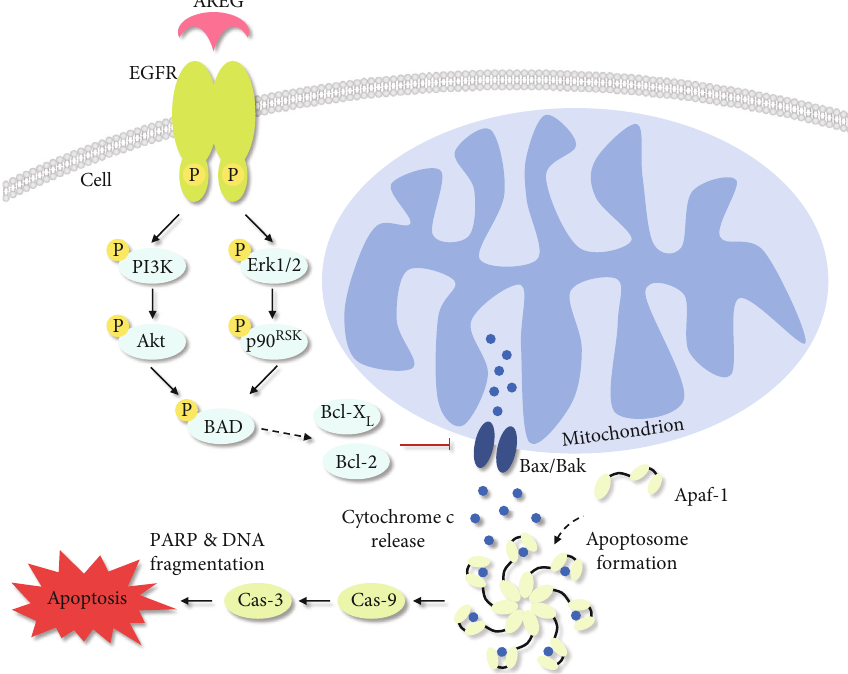
Figure 6: Schematic diagram displaying the impact of AREG on intrinsic apoptosis signaling. Phagocytosis of bacterial pathogens leads to the release of cytochrome c from the mitochondria through the mitochondrial apoptosis-induced channel (MAC), which is formed by the proteins Bax and Bak. In complex with Apaf-1, the released cytochrome c forms the apoptosome, which fi nally activates caspase-3 through binding and activation of caspase-9. Caspase-3 fi nally leads to the initiation of apoptosis. The signaling pathway can be inhibited by AREG-mediated activation of the EGF receptor. Binding of the cytokine AREG leads to an EGFR-mediated activation of the PI3K/Akt and MAPK/ERK pathway, which results in the phosphorylation of the protein BAD. In consequence, the heterodimers of BAD/Bcl-X L and/or BAD/Bcl-2 dissociate, thereby enabling Bcl-2 and Bcl-X to inhibit Bax-induced L